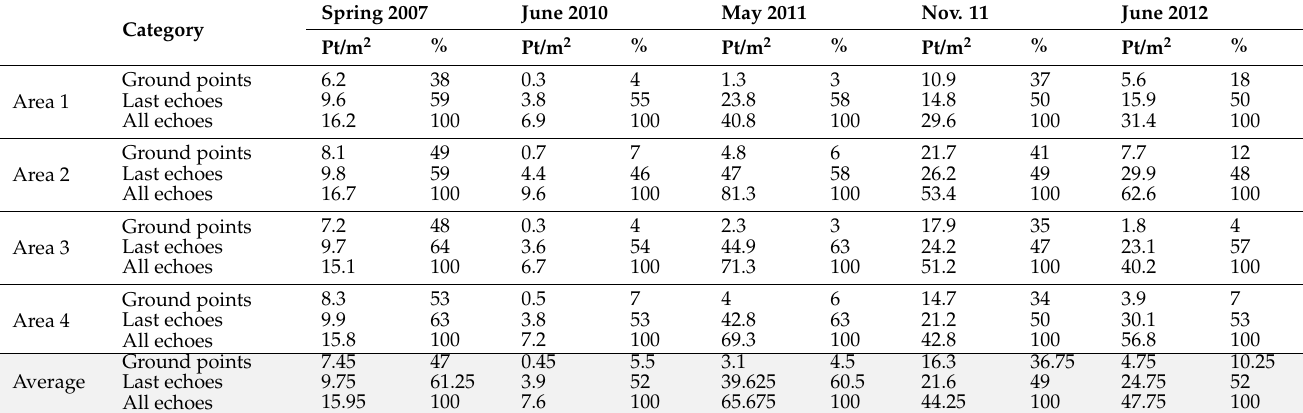
Table 2. Mean point densities and point cloud structure in the four sample areas.